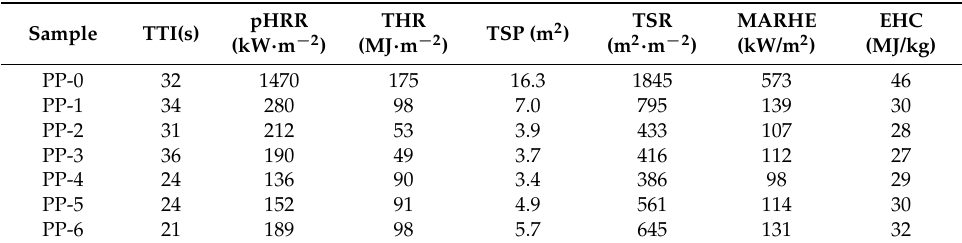
Table 2. Cone calorimetry of PP